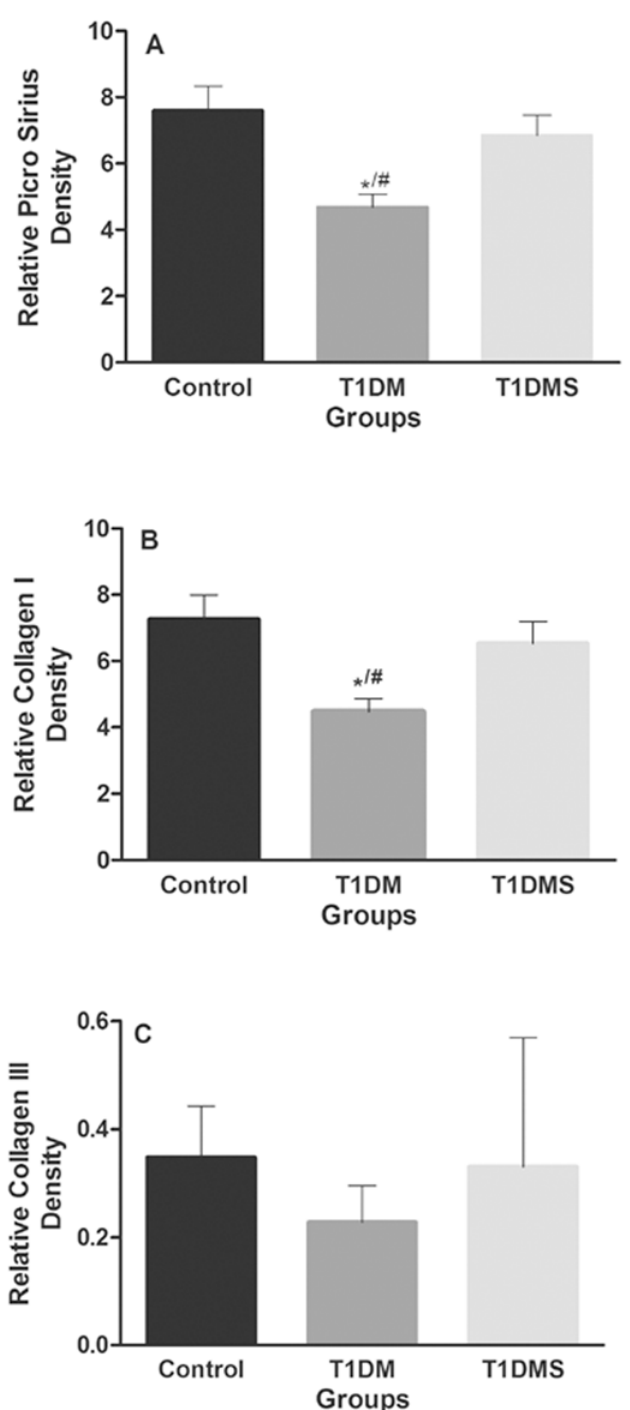
Fig 3. Assessment of collagen deposition by picrosirius red staining. Tibia staining for collagen content (picrosirius red). Total collagen (A), collagen type I (B), and collagen type III (C) contents of the control, type 1 diabetes mellitus (T1DM), and T1DM plus zinc supplementation (T1DMS) groups. All data are shown as means ± SEM. Comparisons between groups were analyzed with Kruskal-Wallis ANOVA on Ranks and Dunn ’ s post-hoc. p < 0.05 * /# vs. control group.